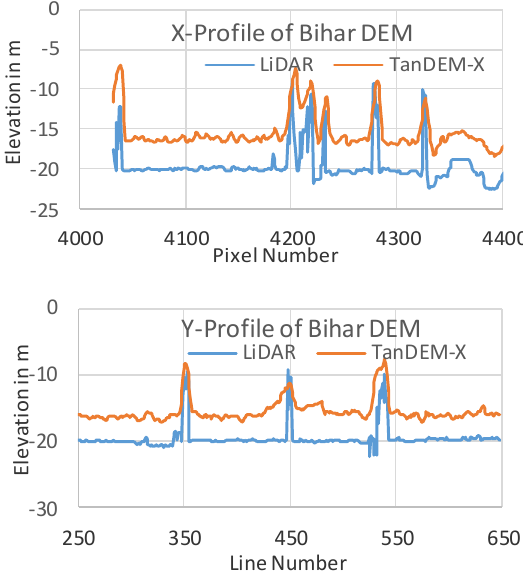
Figure 5. Elevation trend for airborne LiDAR and TanDEM-X DEMs for Bihar test area at a particular location in X-direction and Y-direction of the DEM.